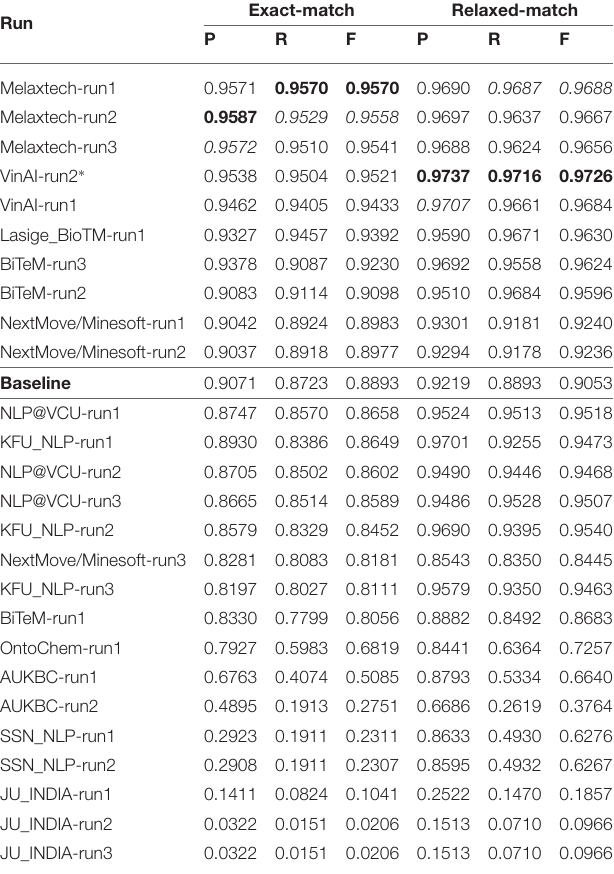
TABLE 6 | Overall performance of all runs in Task 1—Named entity recognition. TABLE 7 | Overall performance of all runs in Task 1—Named entity recognition